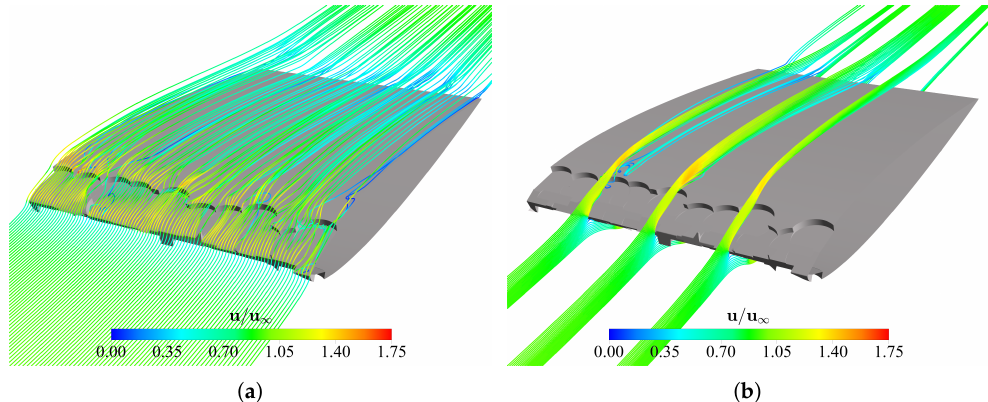
Figure 11. Streamlines around the damaged blade at 4 ◦ incidence. ( a ) Streamlines on the suction side of the blade; ( b ) Streamlines in three xy planes passing through 1/4, 1/2, and 3/4 of the span.